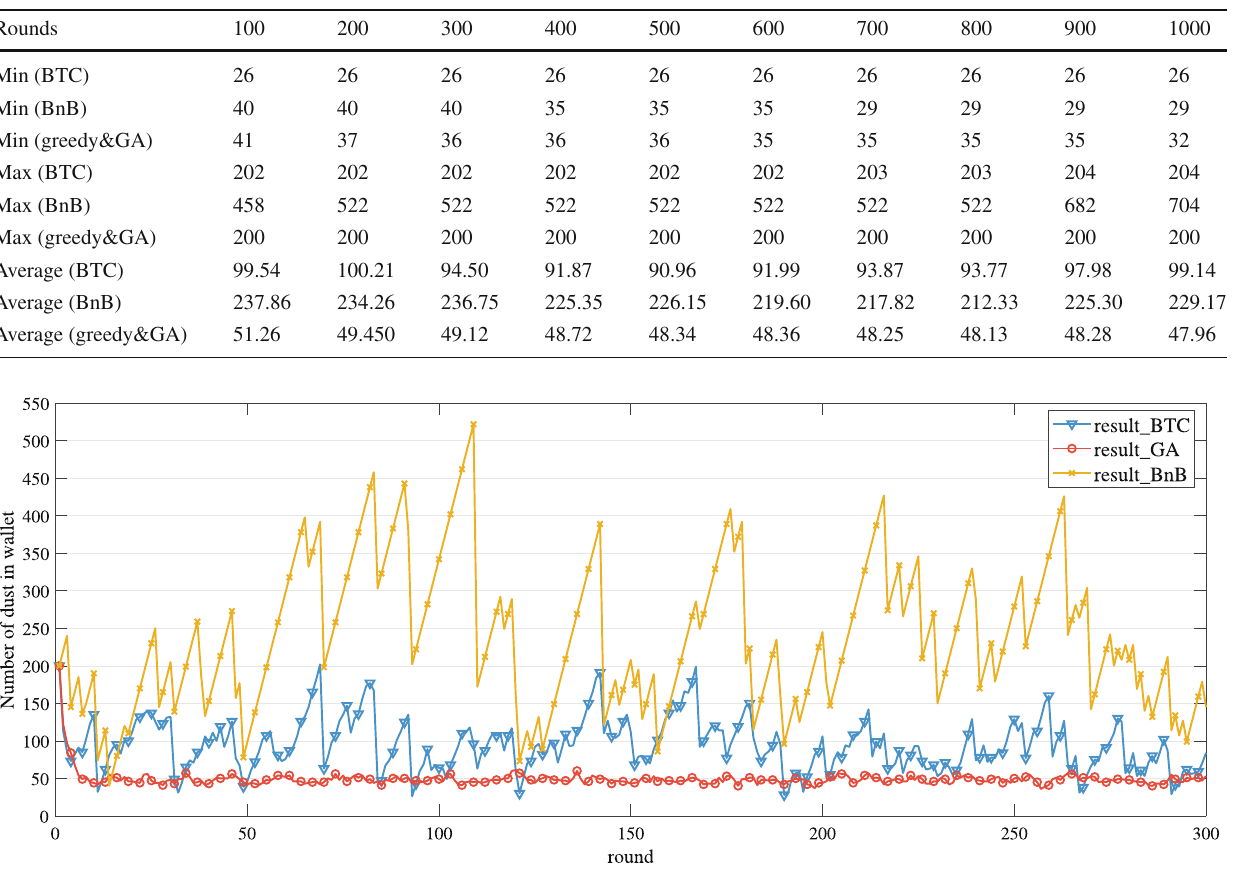
Table 3 Comparison of dust in wallet Rounds